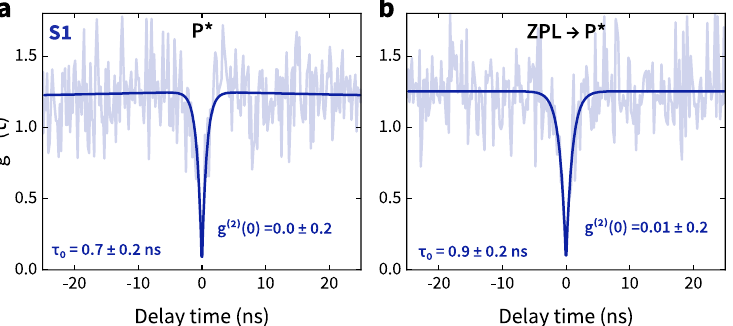
Figure A3. Autocorrelation functions g ( 2 ) ( τ ) for S1 in the P*-line spectral range ( a ) and two-color cross-correlation between photons from P* and ZPL ( b